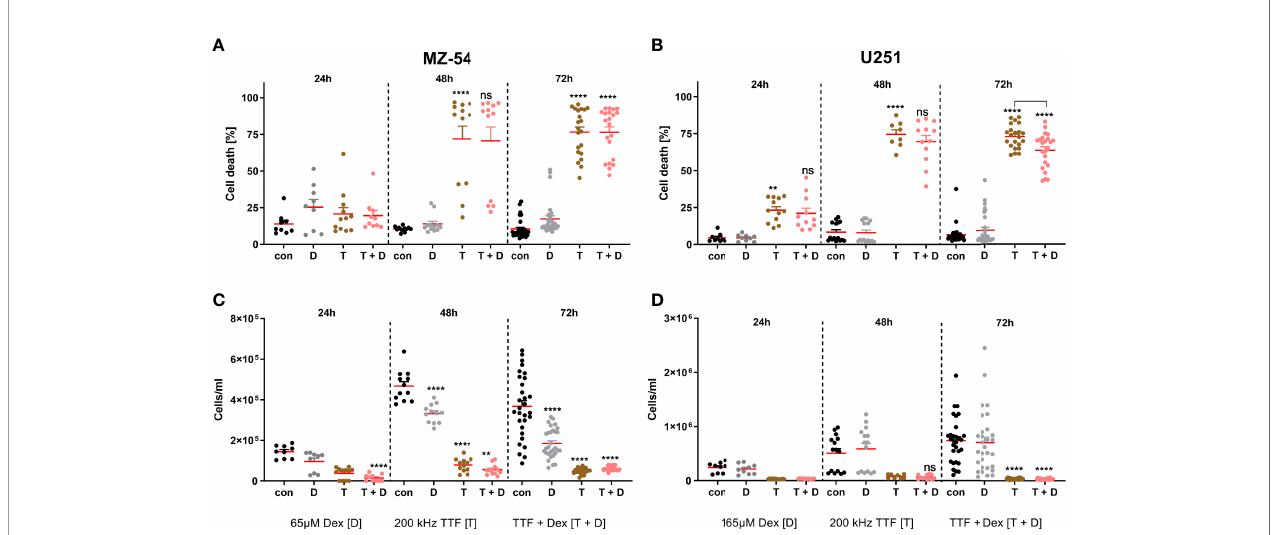
FIGURE 3 | FACS-based measurement of (A, B) cell death and (C, D) cell count of (A, C) MZ-54 and (B, D) U251 GBM cells after treatment with the IC50 of Dex and Tumor Treating Field (TTFields) application at the optimal frequency for 24, 48 and 72h. Effective cell death induction can be appreciated after 48h using TTFields and TTFields + Dex in both GBM cell lines with a concomitant decrease in cell count. Note the MZ-54 also display reduced cell counts after 48h and 72h after Dex alone and U251 already display signi fi cantly induced cell death after 24h. *p < 0.05; **p < 0.01; ***p < 0.001; ****p < 0.0001; ns, non signi fi cant. One-Way ANOVA with Tukey ’ s multiple comparison test (GraphPad Prism 7). Con, control; D, dex; T, TTFields; T + D, TTFields +